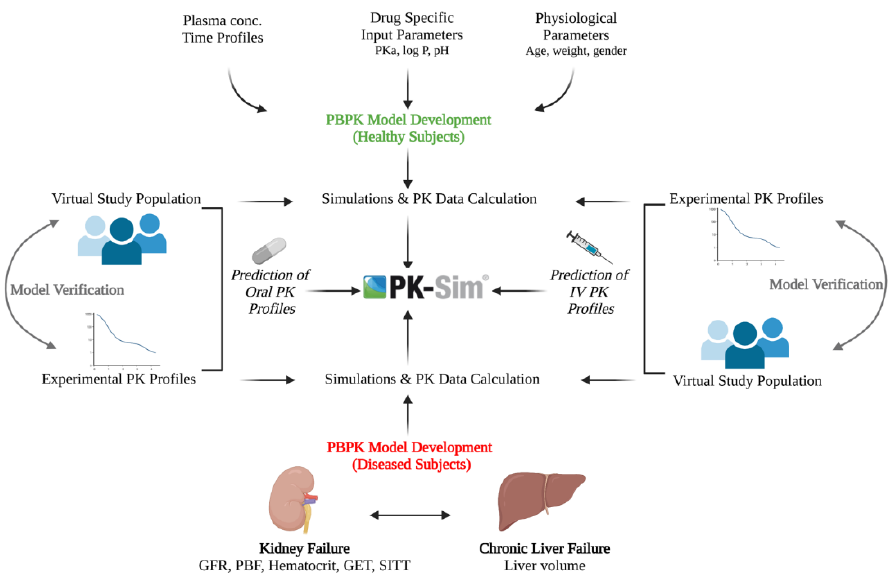
Figure 1. The strategy adopted in the PBPK model of labetalol. GET gastric emptying time, GFR: glomerular filtration rate, IV: intravenous, log P: lipophilicity, pH: the potential of hydrogen, PK: pharmacokinetics, pKa: negative log of the acid dissociation constant, PBF: protein binding factor, SITT; small intestinal Transit time. The figure was created with BioRender.com with agreement number LY24EZHS7O.